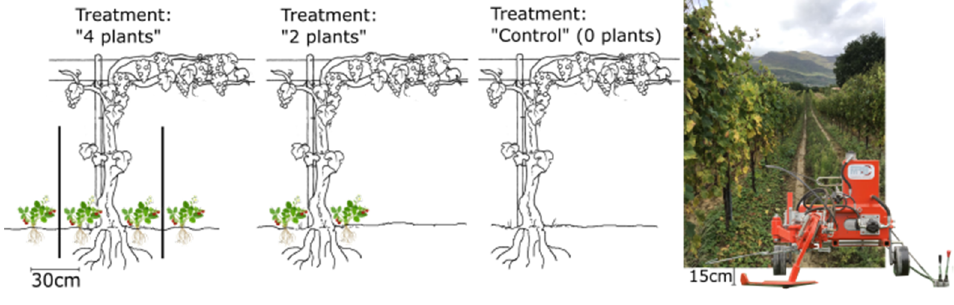
Figure 2. Scheme of the treatments. On the right the in-row horizontal blade weeder, which works 15 cm deep. In the “4 plants” treatment, note the position of the iron rods between the strawberry